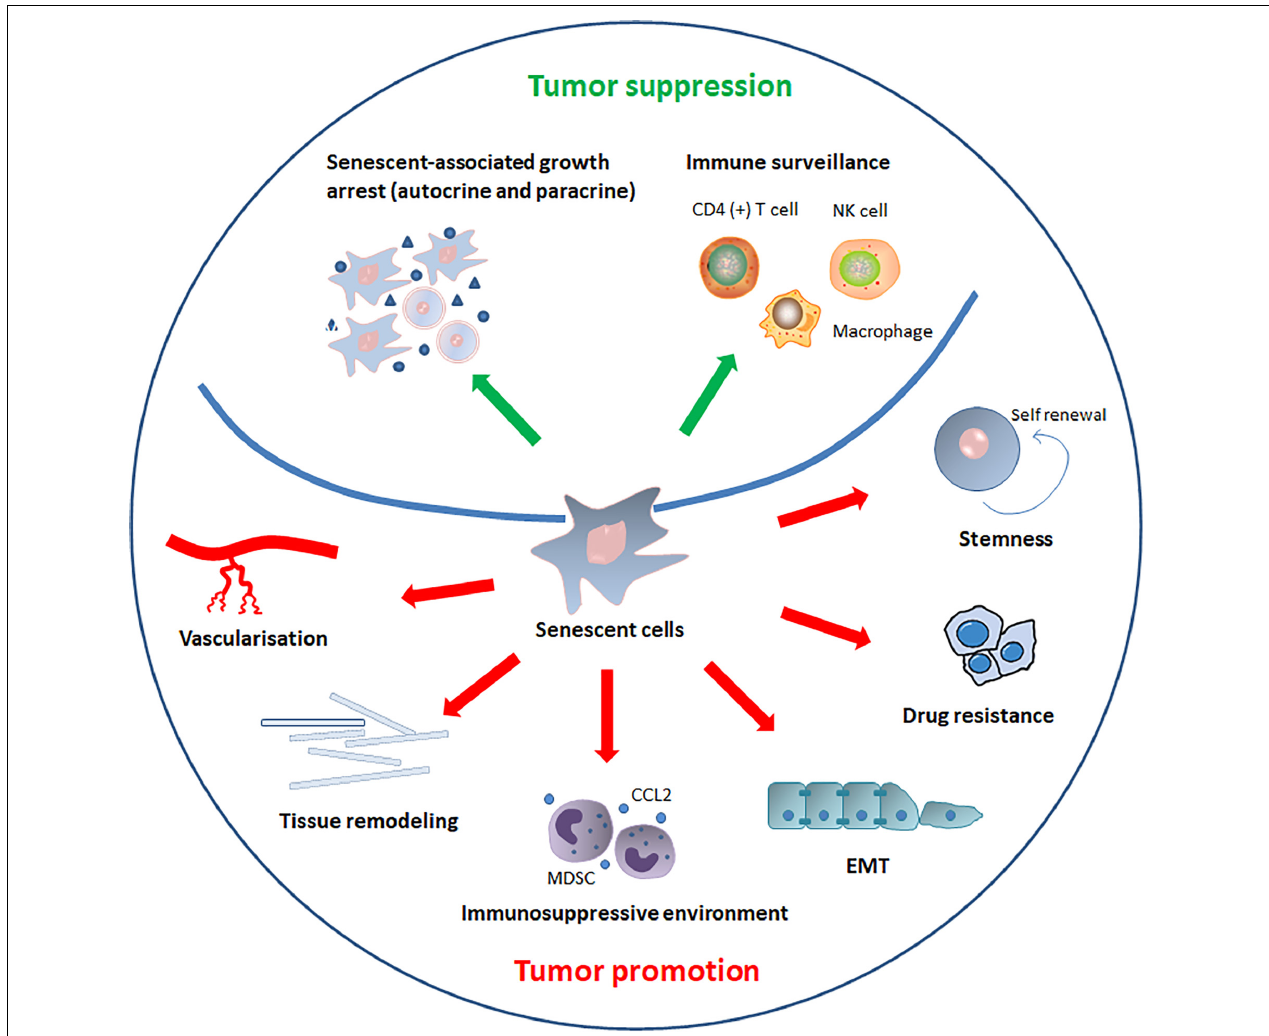
FIGURE 3 | The role of senescence in cancer. SASP components induce or enhance the senescent-associated growth arrest in autocrine and paracrine manners, thereby inhibiting cancer progression. In addition to reinforcing senescence, SASP can also activate immune surveillance, which is orchestrated by specific immune responses mediated by antigen-specific CD4 (+) T cells. SASP also recruits natural killer (NK) cells and alters macrophage polarization to eliminate senescent tumor cells and suppress tumorigenesis. By contrast, senescent cells and SASP components can directly or indirectly promote tumor cells growth, invasion and metastasis by promoting tumor vascularization, maintaining stem-cell features, creating an immunosuppressive environment, remodeling tissue structure, inducing drug resistance, and stimulating epithelial-mesenchymal transition